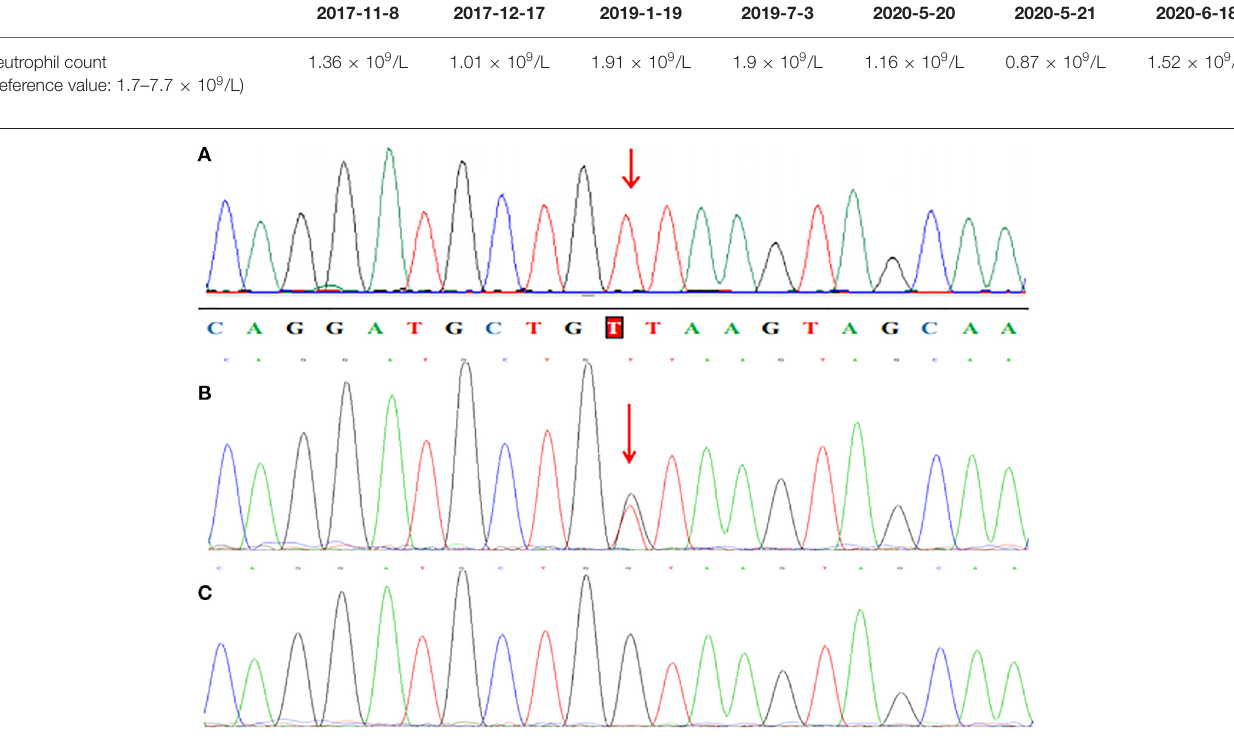
FIGURE 3 | Partial sequence chromatograms of VPS13B . The red arrows represent the mutation site. (A) Homozygous c.6940 + 1G > T splice-site mutation. (B) Heterozygous c.6940 + 1G > T splice-site mutation. (C) Normal DNA sequence.